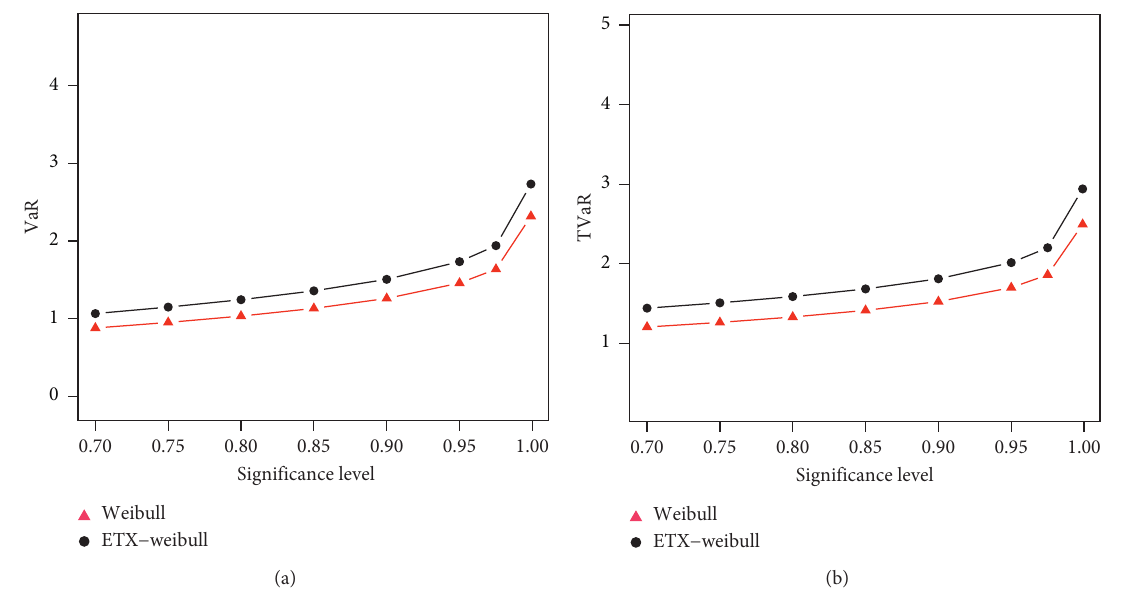
Figure 8: Plots for the VaR and TVaR of the Weibull and ETX-Weibull distributions. Table 3: The estimated values of the parameters with standard errors (in parenthesis) of the fitted distributions. Dist.